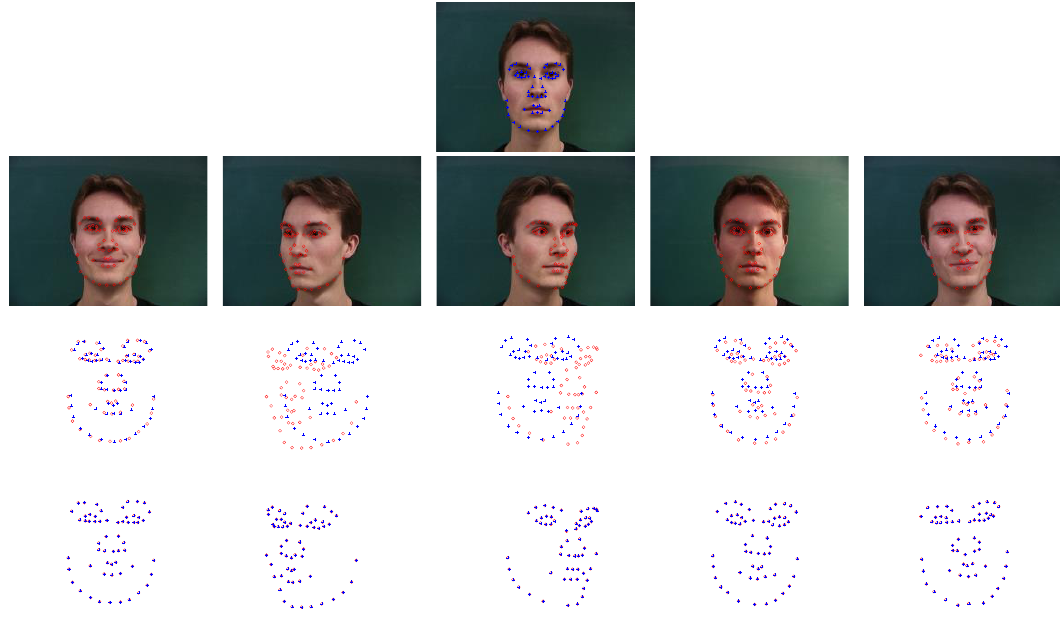
Figure 5. Registration results on some examples on the IMM face dataset. The first row is the original image of view 1, and the annotated landmarks are employed as model point set. The second row is the original images from view 2 to view 6, and the annotated landmarks are employed to the scene point sets. The third and fourth rows are the point sets to be registered and the registration results, respectively. The model points are marked by “ +, ” and the scene points are marked by “ o. ”